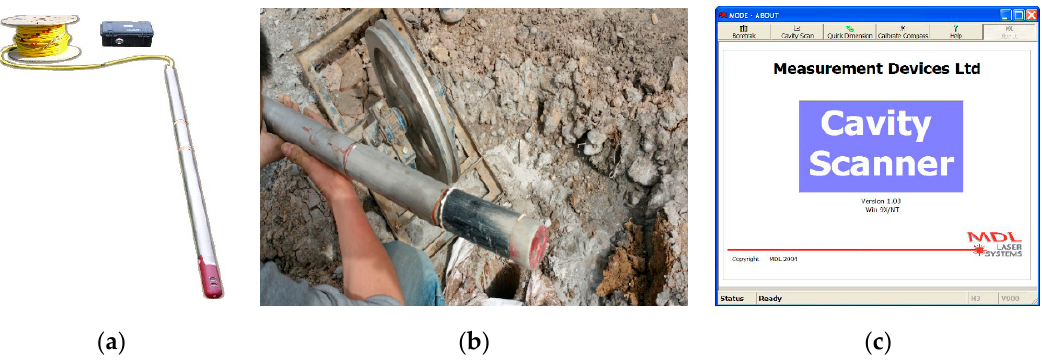
Figure 14. Laser scanning equipment and operation interface. ( a , b ) Laser scanning equipment; ( c ) operation interface.